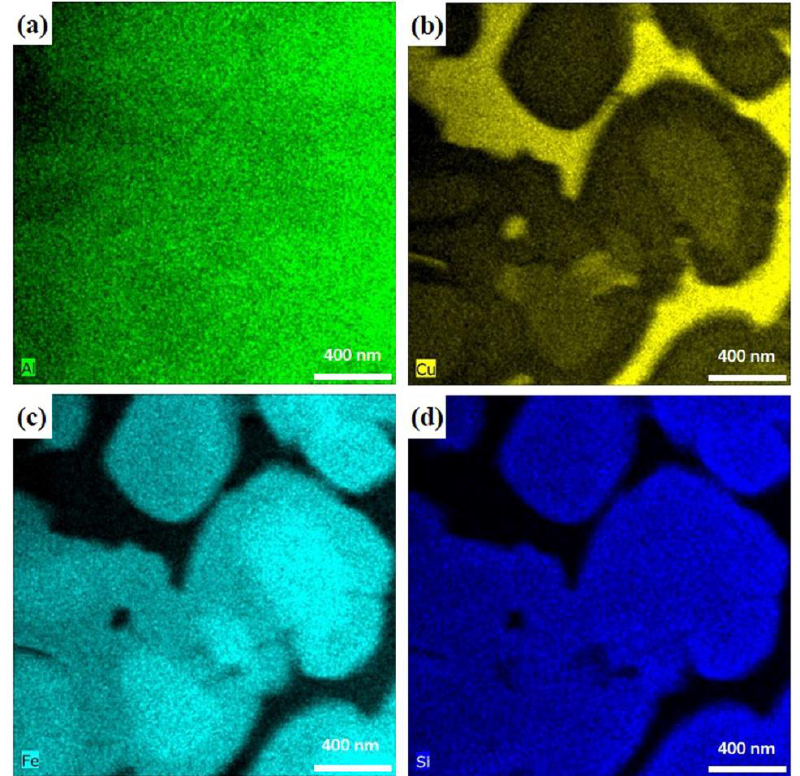
Figure 4. Element maps of feedstock powder, measured by EDS equipped in TEM ( a ) Al; ( b ) Cu; ( c ) Fe; ( d )